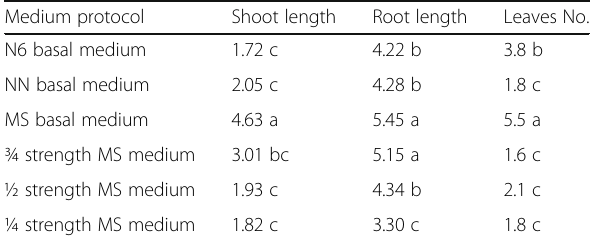
Table 2 Means of shoot, root length (cm), and leaves number as influenced by media protocols of